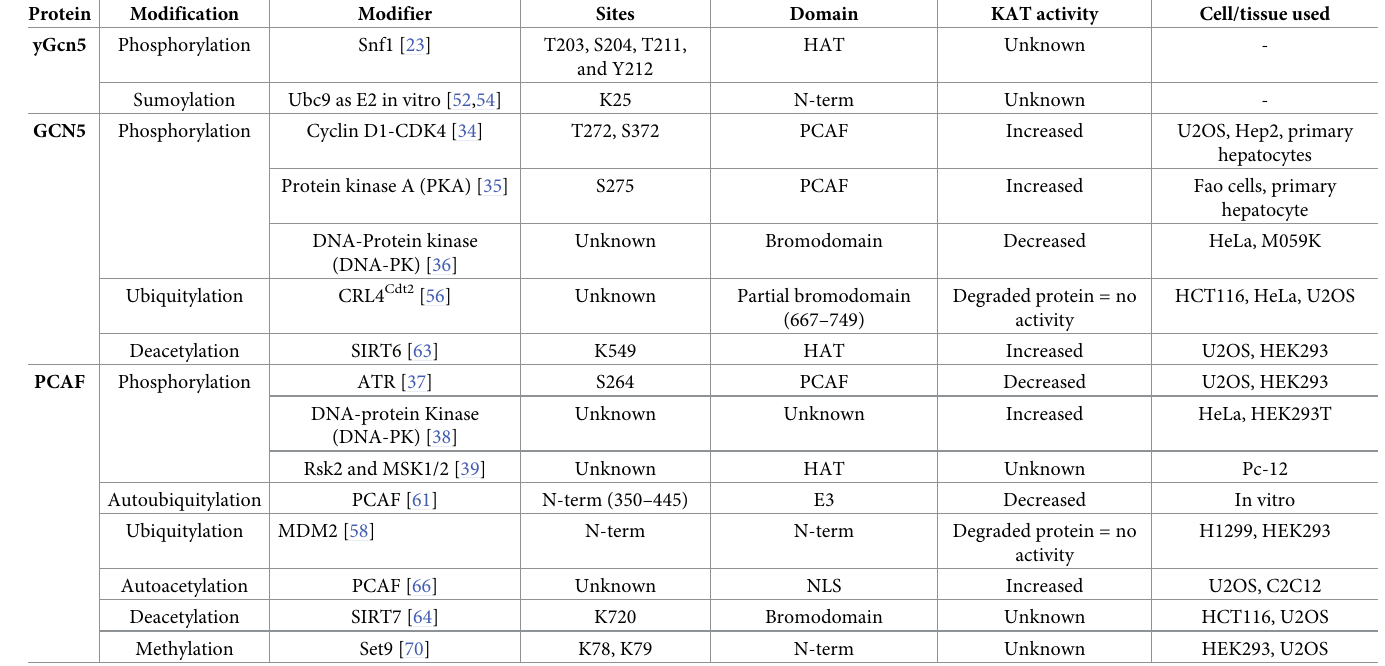
Table 1. Posttranslational modifications of Gcn5-like acetyltransferases in yeast and mammalian cells.